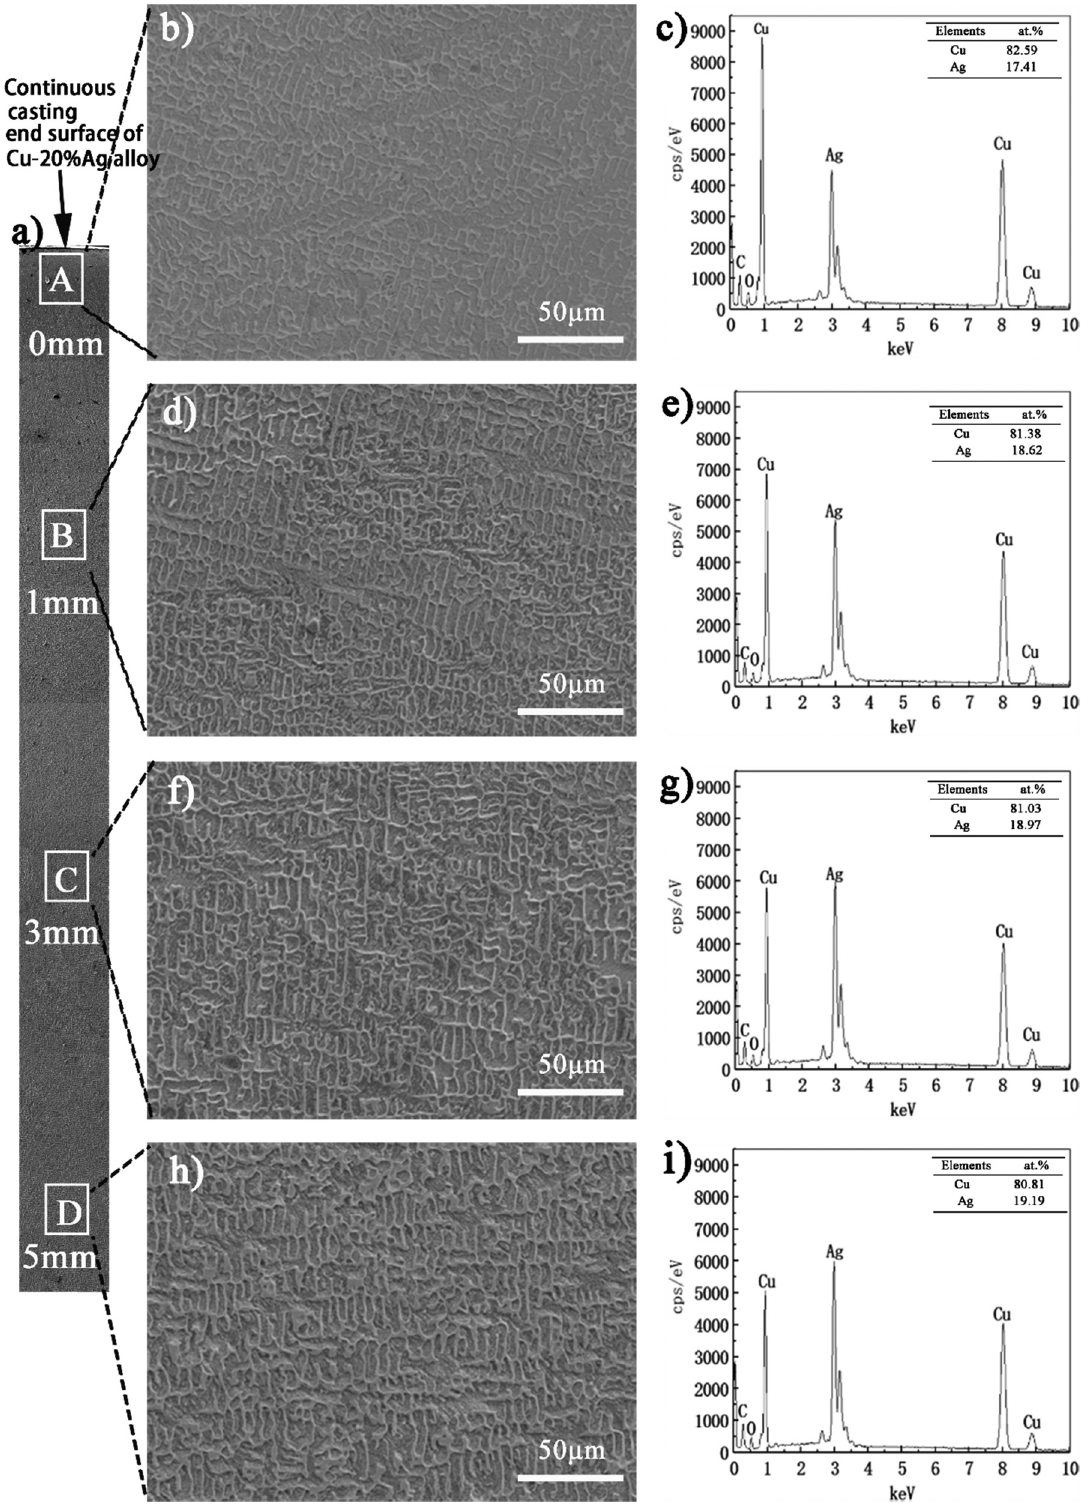
Figure 3: SEM image and elemental EDS elements spectrum of 5 mm end of continuous surface elemental analysis diagrams of Figure 3 ( b,d,f, mainly composed of copper and silver elements, and and h ) , respectively. The entire SEM selection area is when far from the end, the content of silver in the